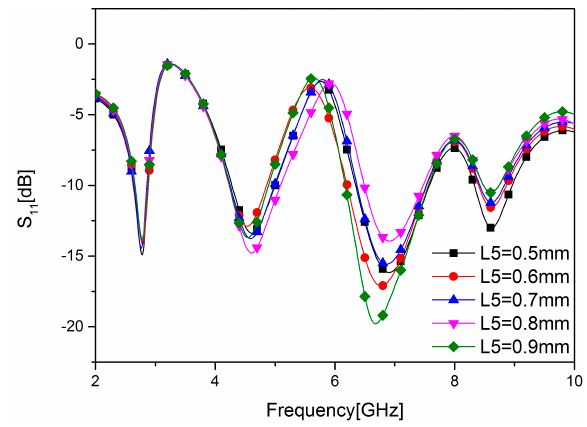
Figure 6. Effect of parameter W 3 on the simulated return loss. Information 2018 , 9 , x FOR PEER REVIEW